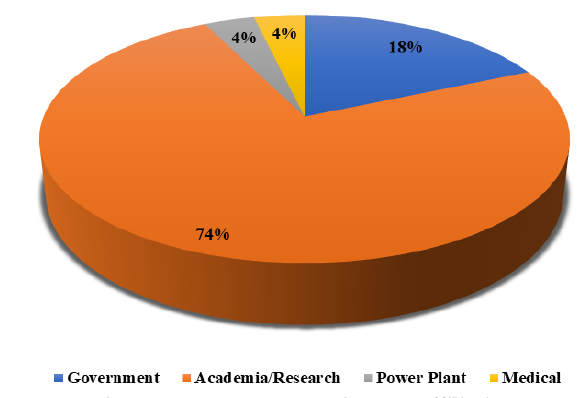
Figure 4. Survey response by U.S. affiliation